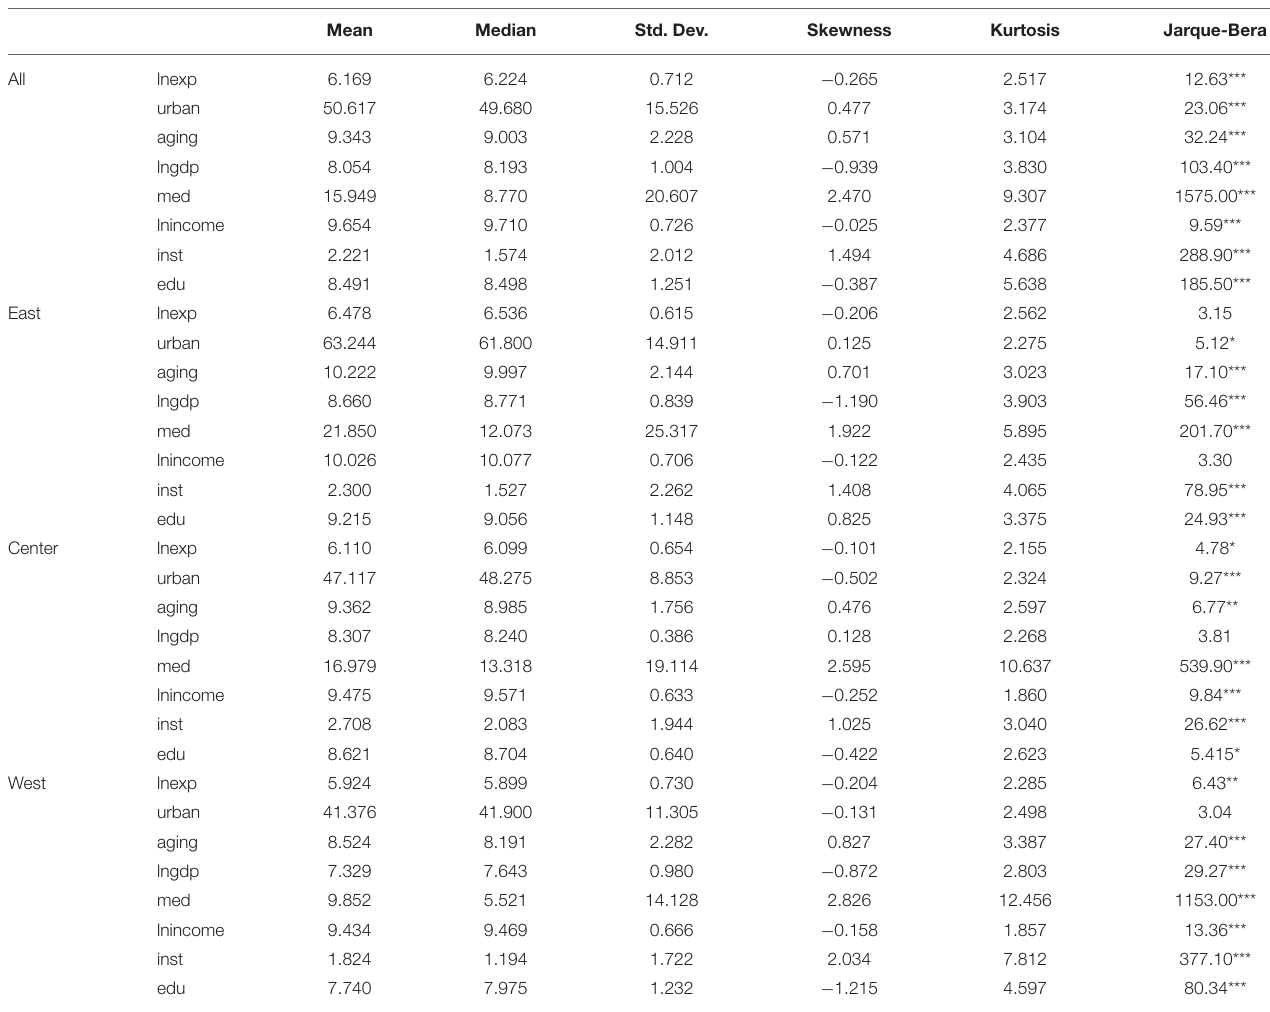
TABLE 1 | Descriptive statistics of the variables. Mean Median Std. Dev.